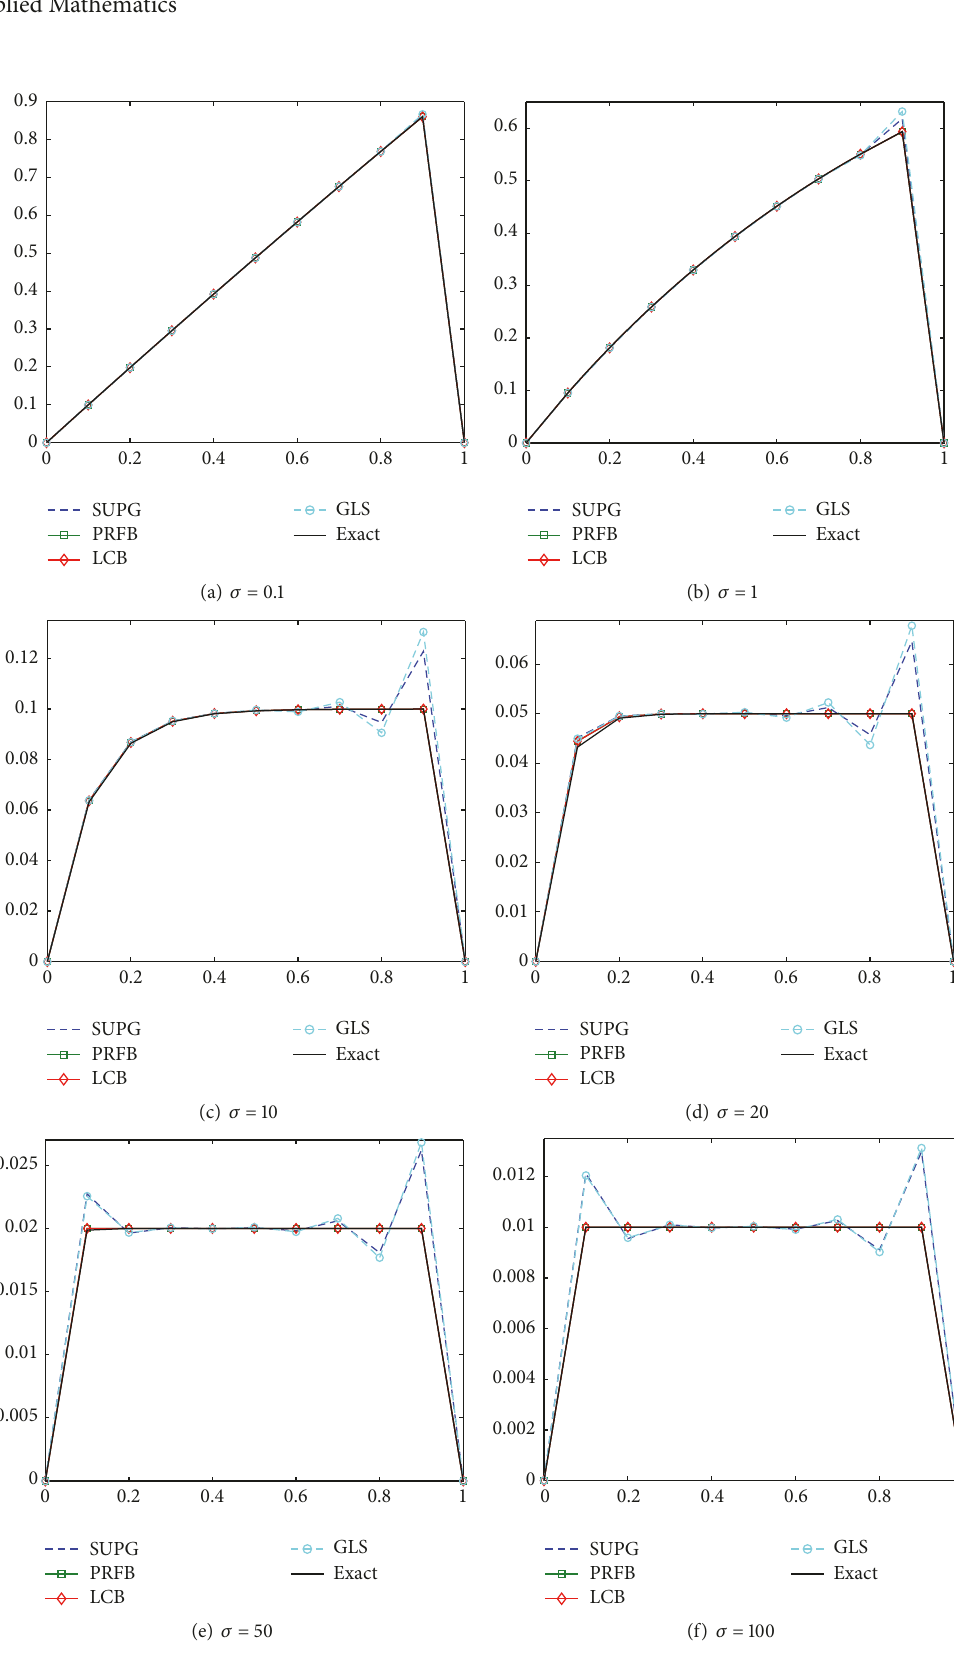
Figure 6: The numerical solutions and the exact solution for several values of 𝜎 when 𝑓(𝑥) = 1 and 𝜖 = 10 −5